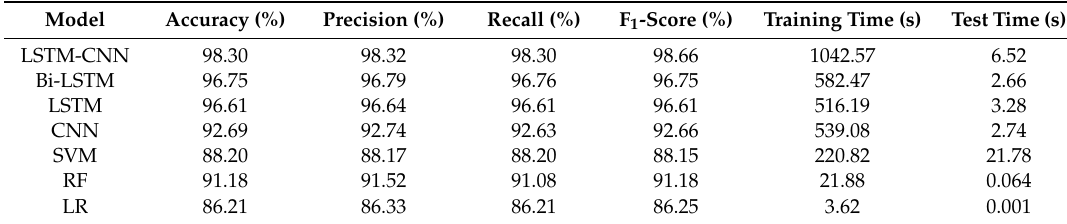
Table 8. Comparison of identification results of this model with other